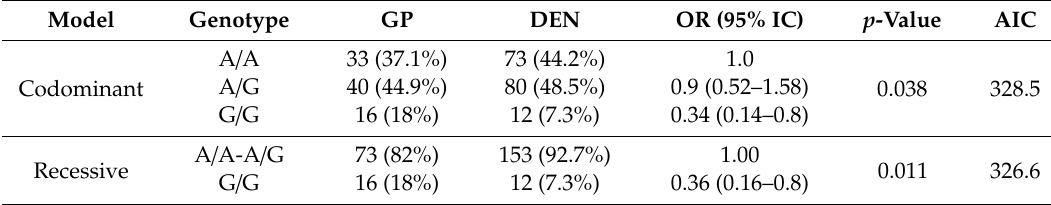
Table 5. Association of TLR4-rs 2737190 with the response group (DEN) ( n = 254).